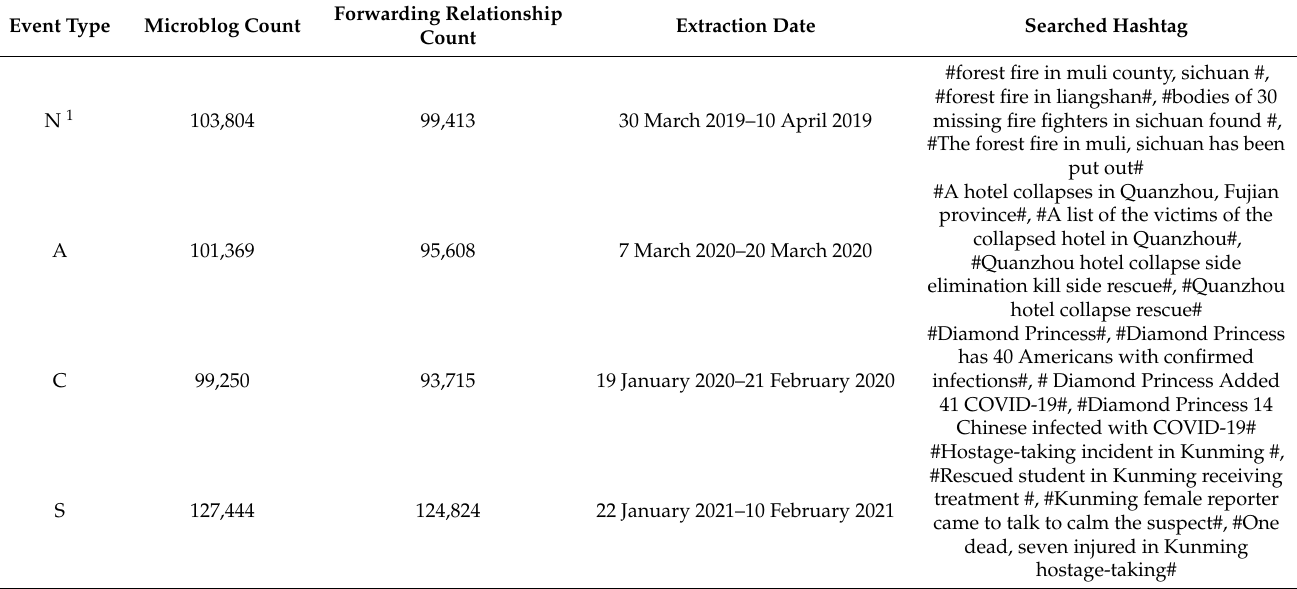
Table 1. The numbers of microblog entries and forwarding relationship at each event.